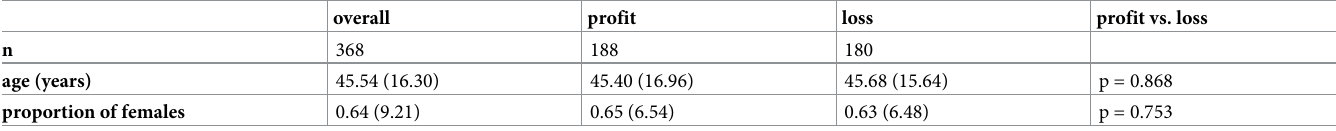
Table 7. Age and gender by outcome in Study